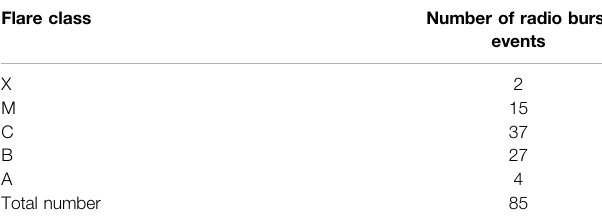
TABLE 2 | Event list of MUSER in 2014 – 2019.